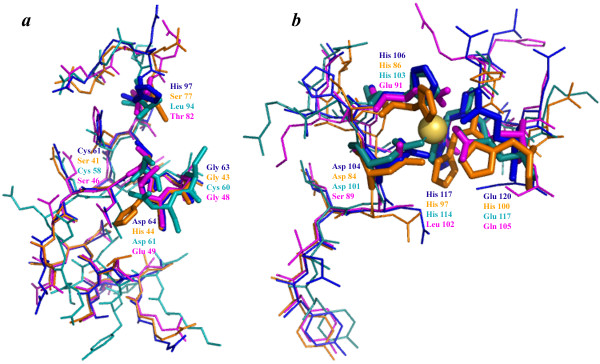
Superimposition of (a) α3N and (b) α5 metal binding sites of Synechococcus SmtB (blue color), S. aureus CzrA (orange), S. aureus CadC (teal), and Vc-HlyU (magenta).